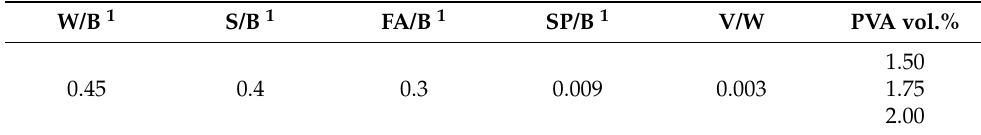
( e ) ( f ) Figure 1. Order of creation of TCPA with nylon fishing line. ( a ) Nylon fishing line cut to specified length. ( b ) Twisting with tension acting on the fiber. ( c ) Coiled from fiber ends. ( d ) Continued tor- sion results in a coiled shape over the entire fiber length. ( e ) Wrap stainless steel fiber around TCPA for heating. ( f ) Completed TCPA. 2.4. TCPA Performance Evaluation Test Specimens shown in Figure 2 were produced to examine the influence of temperature on shrinkage of the TCPA. A DC current was applied to a stainless-steel wire and the temperature was measured by several thermocouples to measure the surface temperature and shrinkage of TCPA.